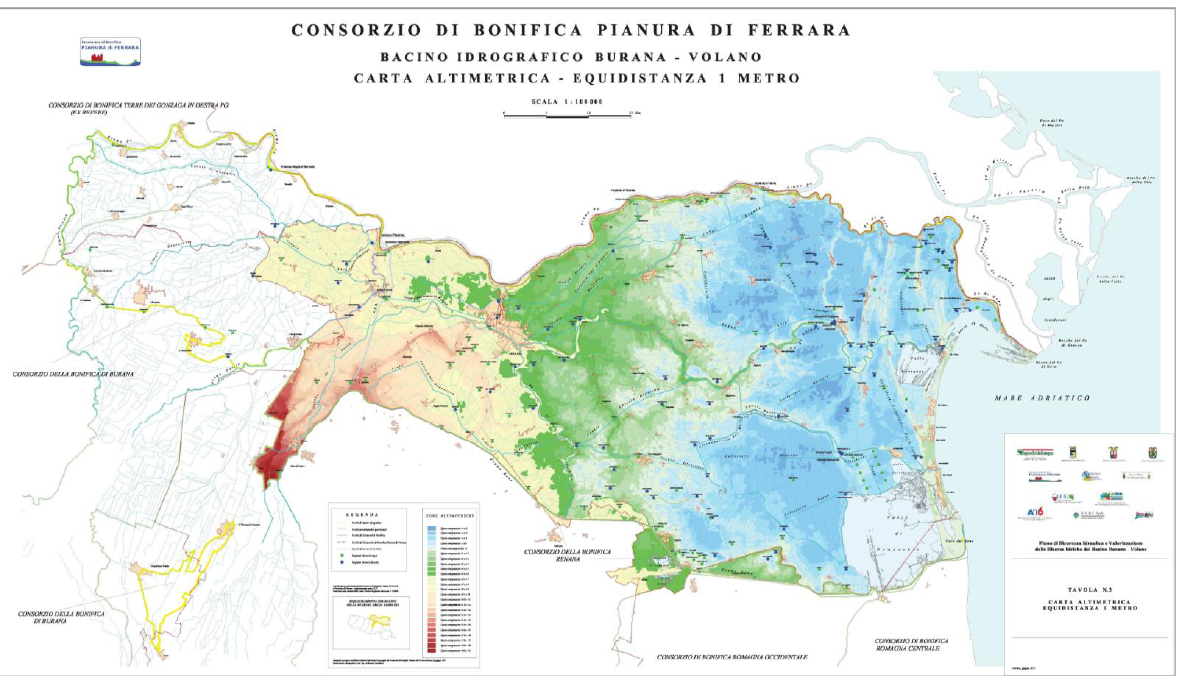
Figure 2. Ferrara territory altimetry (The map can be downloaded from https://www.bonificaferrara. it and has been released from “Consorzio di Bonifica Pianura di Ferrara”; accessed on 15 October